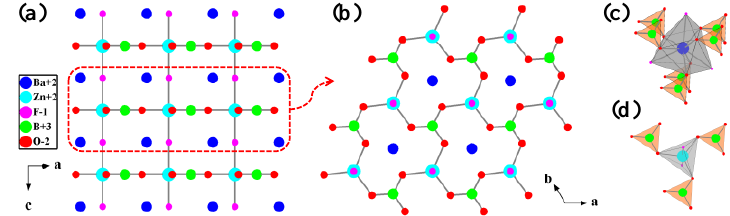
Figure 10. ( a ) Crystal structure of BaZnBO 3 F viewed along the b -axis; ( b ) Flat 2 ∞ [ZnBO 3 F] layer; ( c ) [BaO 6 F 3 ] 13 − polyhedron connects to six [BO 3 ] 3 − groups; ( d ) [ZnO 3 F 2 ] 6 − trigonal bipyramid connects to three [BO 3 ] 3 − groups. Adapted from Ref. [29], Copyright (2018) with permission from Elsevier. Ba 5 Zn 4 (BO 3 ) 6